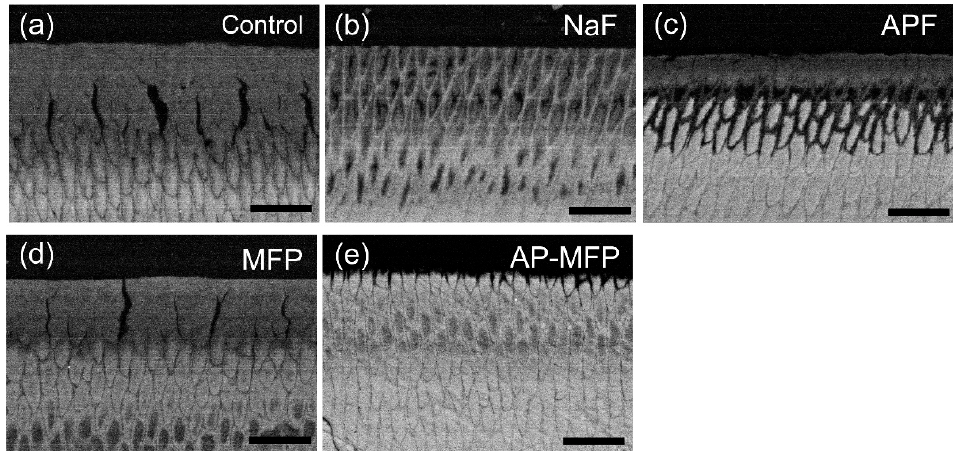
Figure 3. Cross-sectional SEM images of the samples from the ( a ) control, ( b ) NaF, ( c ) APF, ( d ) MFP, and ( e ) AP-MFP groups. Scale bar is 10 μ m. All images were recorded at 2000-fold magnification.